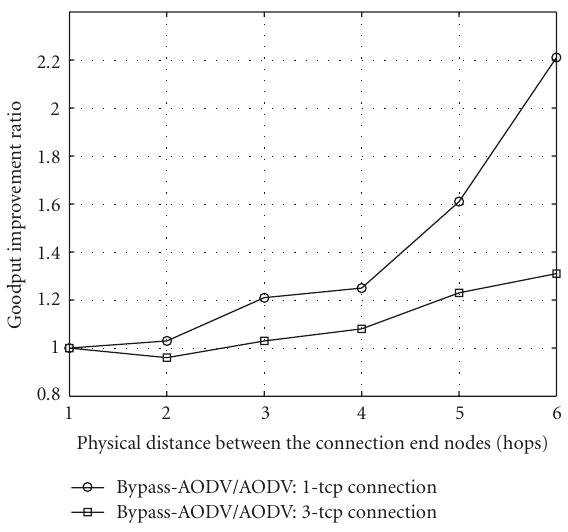
Figure 12: Goodput improvement ratio (Bypass-AODV/AODV).